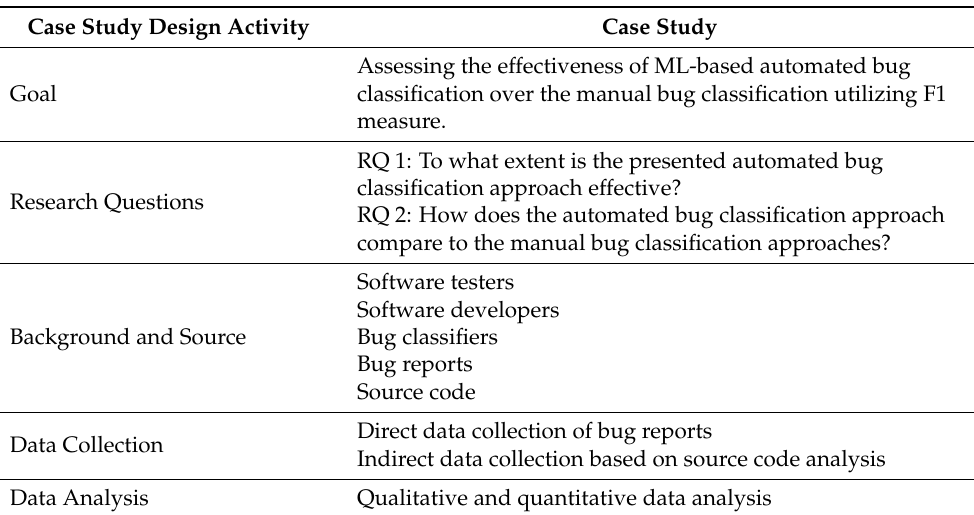
Table 3. Case study design of evaluation protocol adopted from